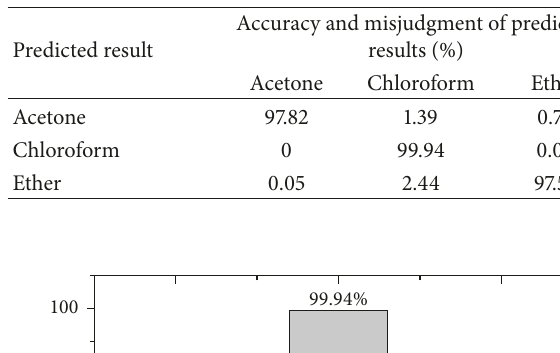
Table 1: Accuracy and misjudgment situation of predicted results of each chemical molecule.